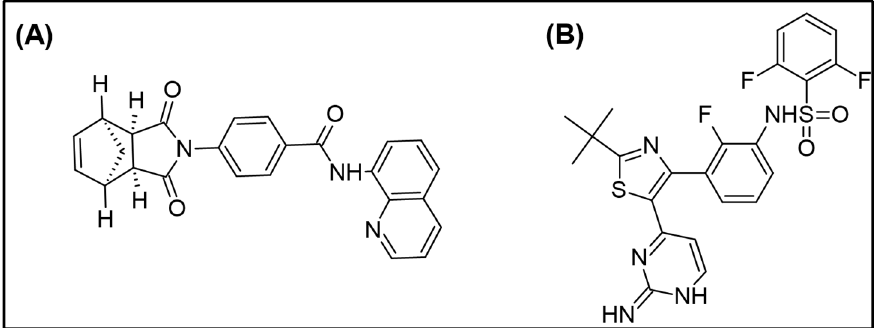
Figure 1. Structure of ( A ) IWR-1 endo and ( B ) ISTD, dabrafenib.